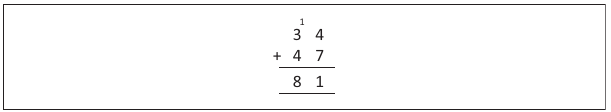
FIGURE 1: An illustration of the standard written algorithm (SWA) for